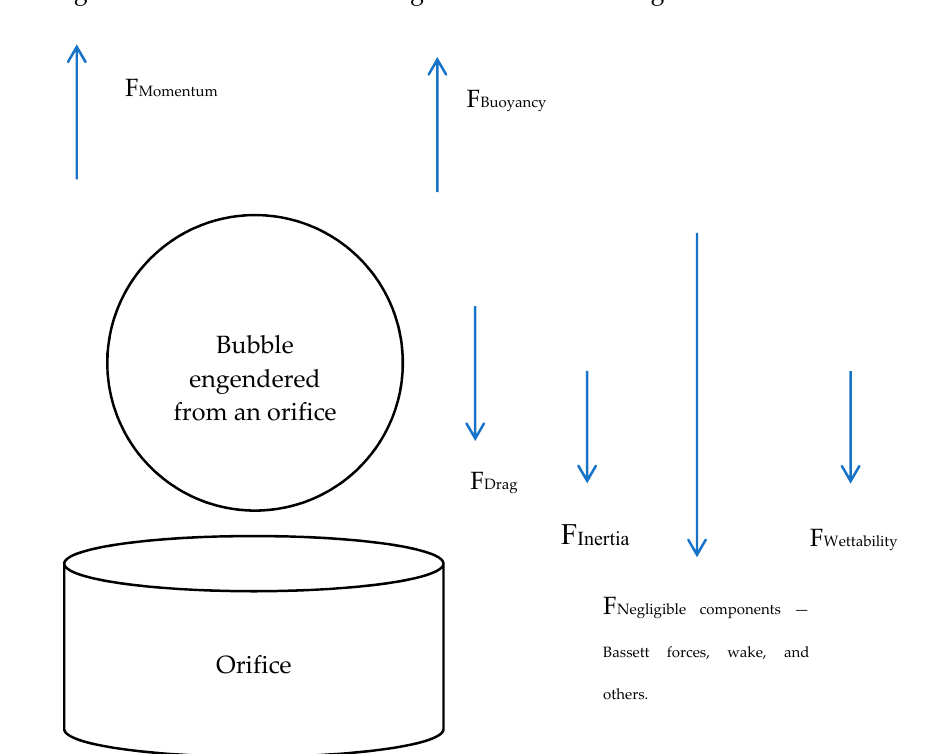
Figure 11. Bubble forces resolved (adapted from [52]).